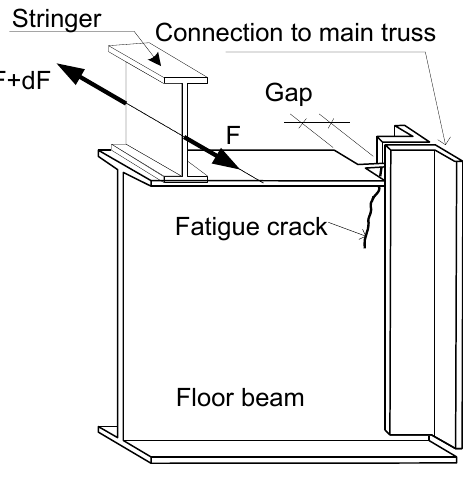
Figure 19. Fatigue cracking in the floor-beam web caused by the transverse bending deformation generated by the interaction between the floor system and the main trusses in the